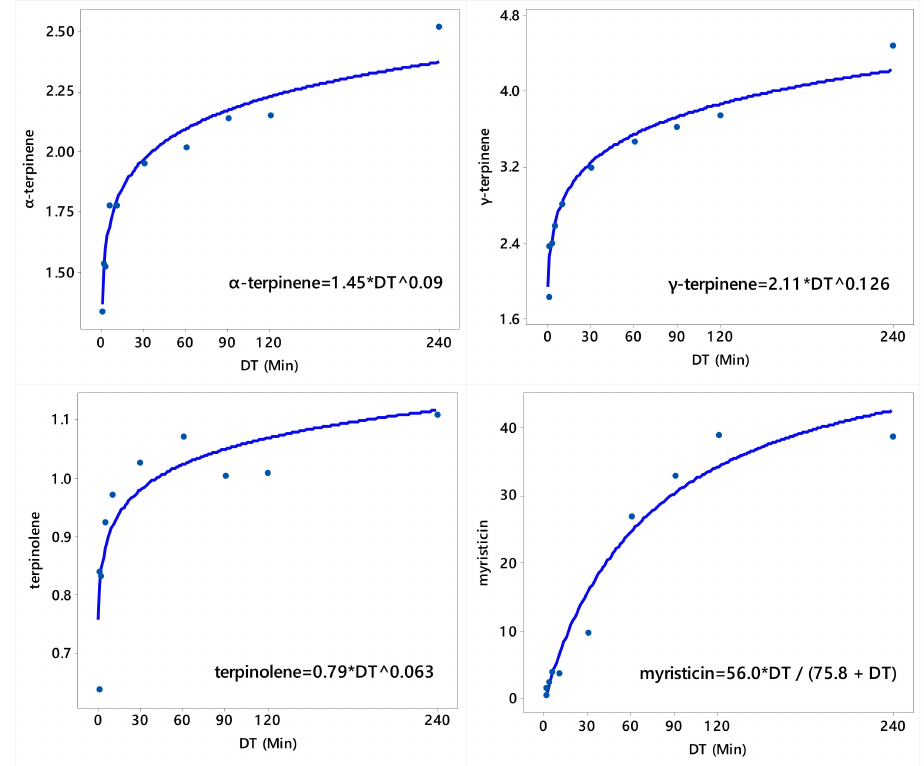
Figure4. Plotofdistillationtime(DT)vs. theconcentrations(%)of α -terpinene, γ -terpinene, terpinolene, and myristicin along with the fitted (solid line) power regression model (for α -terpinene, γ -terpinene, and terpinolene) and Michaelis–Menten regression model for myristicin.